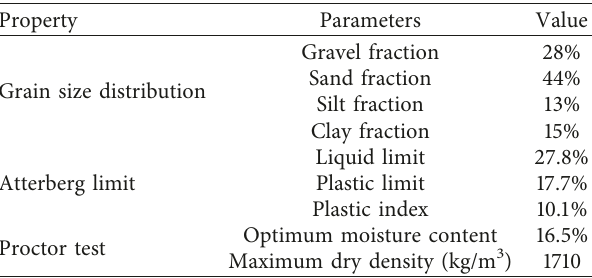
Table 1: Summary of soil properties.